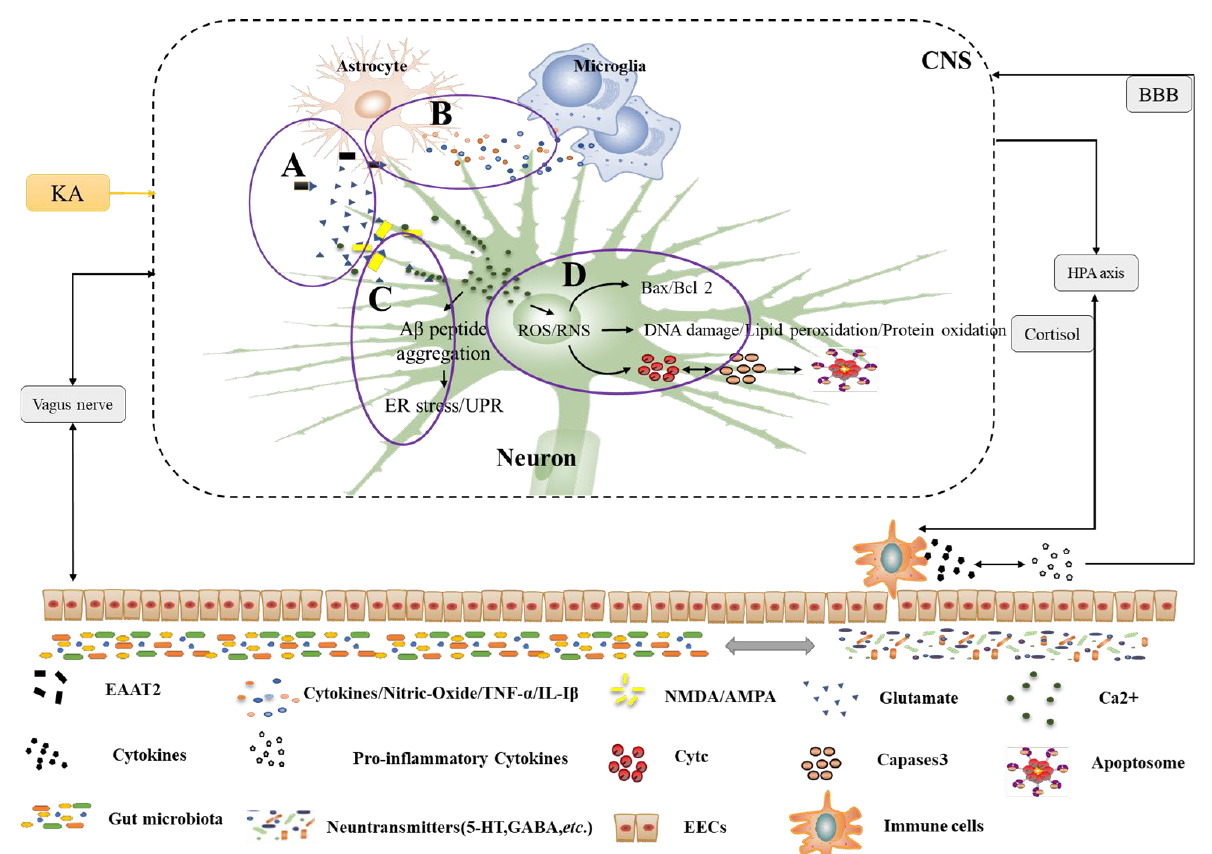
Figure 2. Pathogenesis of NDs under the microbe – gut – brain axis system. A. Excitotoxins. Glutamate is released from neurons and binds to receptors (NMDA, AMPA), along with glutamate uptake by excitatory amino acid transporter 2 (EAAT2) in astrocytes and the action of external factors (e.g., KA) all lead to increased glutamate excitotoxicity, thus promoting Ca 2+ flow, endoplasmic reticulum stress, and pro-apoptotic signaling cascades. B. Neuroinflammation. Interactions between glial cells predispose to neuroinflammation, especially astrocytes and microglia. They may produce several cytokines and oxidants (e.g., TNF- α and IL-I β by astrocytes, nitric oxide, and pro-inflammatory cytokines by microglia) that bind to cell surface death receptors and activate pro-apoptotic signaling cascades. C. Endoplasmic reticulum stress. There are many causes of endoplasmic reticulum stress, mainly abnormal folding of A β peptides and activation of the unfolded protein response (UPR).